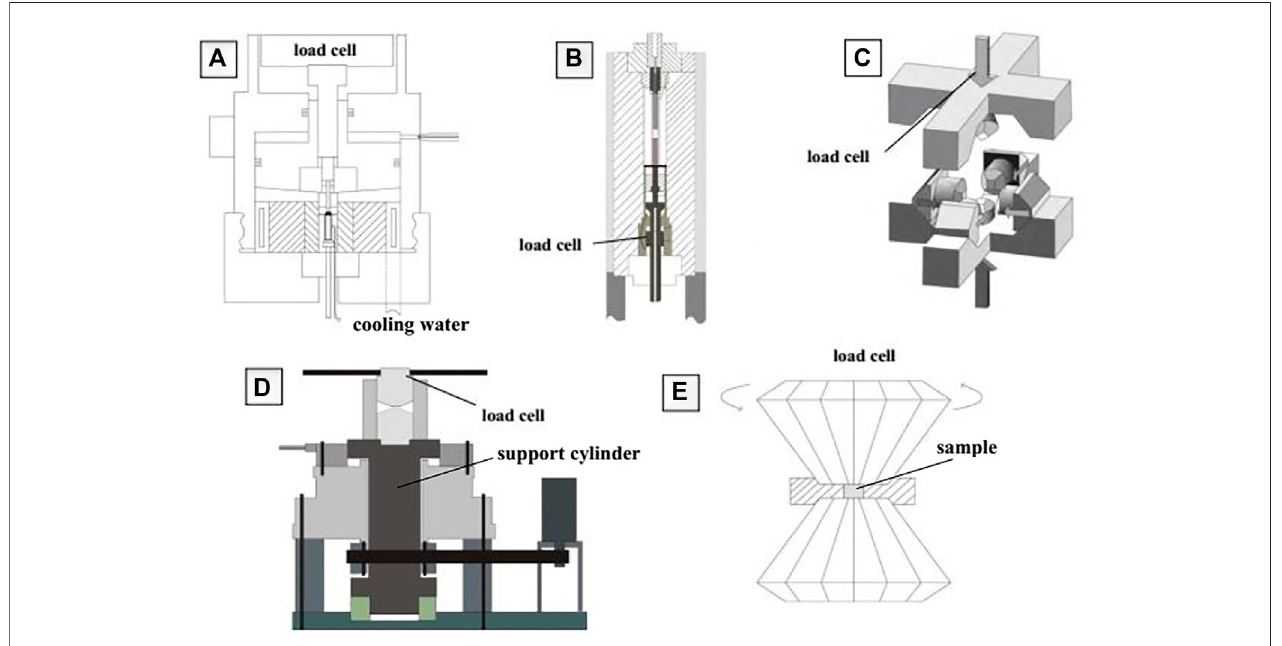
FIGURE1| Differentialstressapparatus. (A) Griggsdeformationapparatus(Griggs,1967), (B) Patersondeformationapparatus(Paterson,1970), (C) Deformation- DIA (Wang et al., 2003), (D) Rotational Deformation Apparatus (Yamazaki and Karato, 2001), (E) Diamond anvil cell (Niwa et al., 2012).